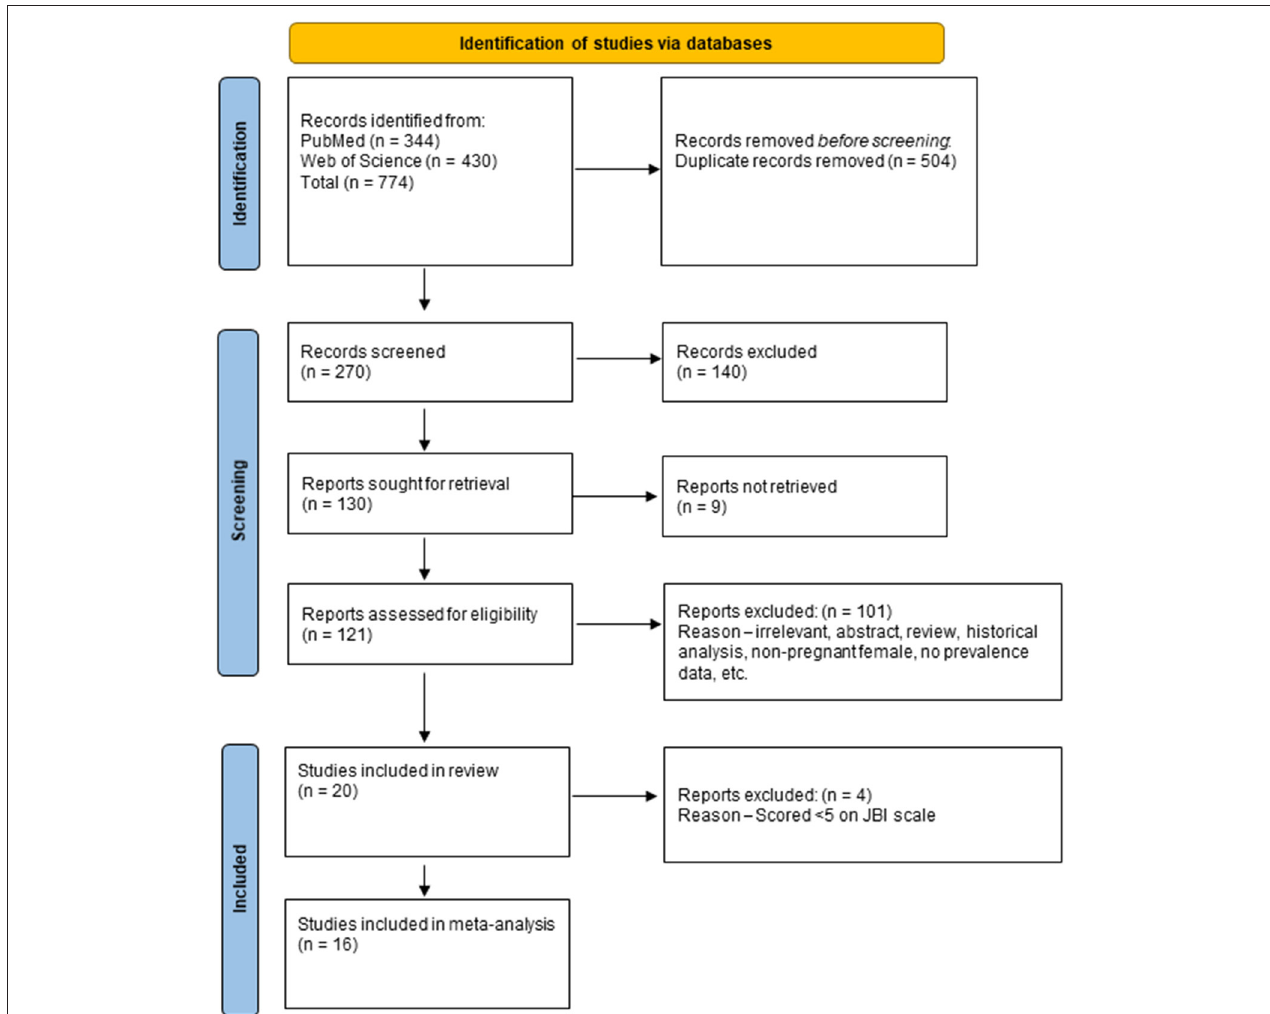
FIGURE 1 | PRISMA flow chart for study selection